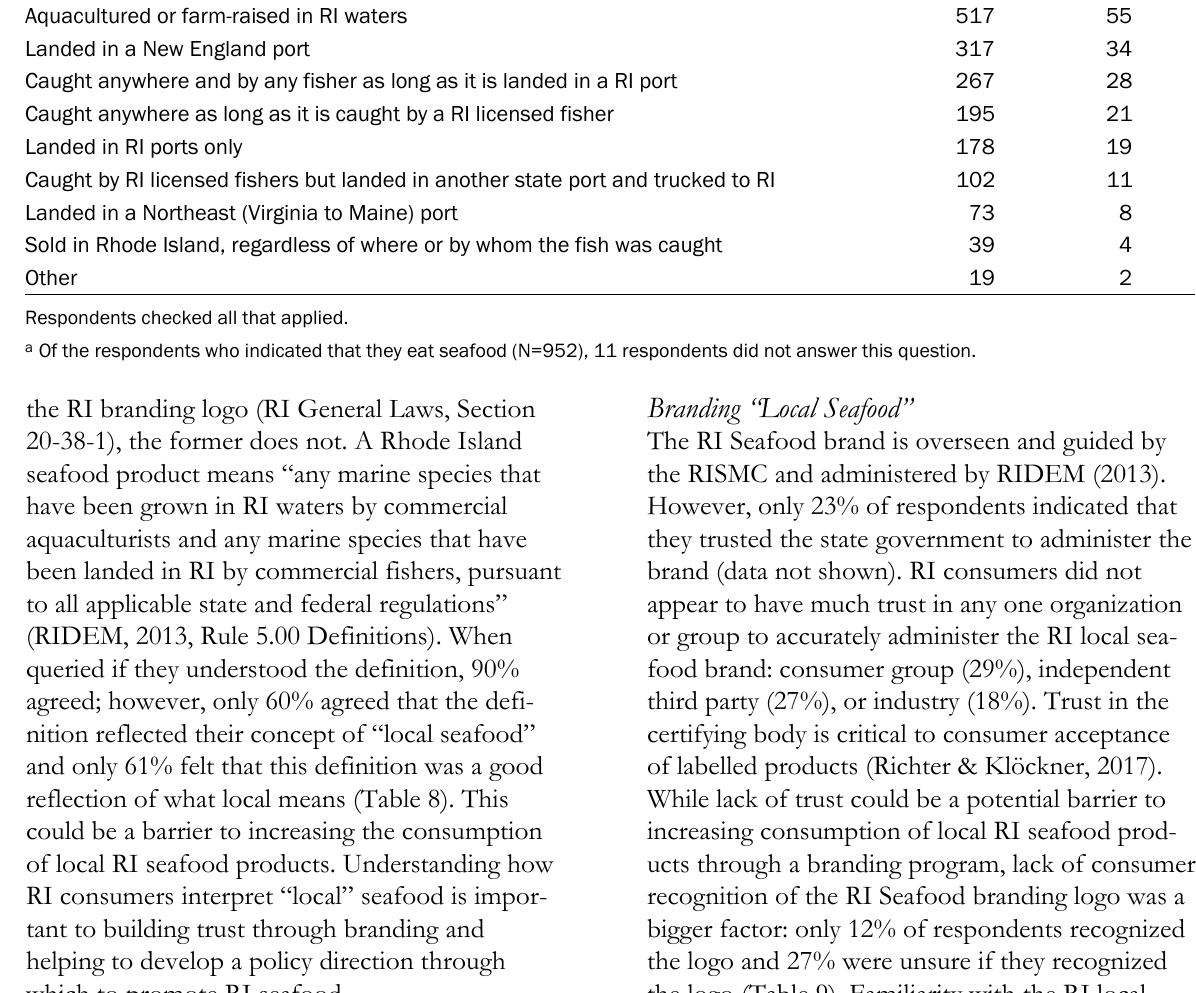
Table 7. Rank Order of Rhode Island Consumer Interpretation of “Local Seafood” ( N =941 a ) Fish or Shellfish Species Caught within Rhode Island (RI) state waters (the 3-mile limit) Aquacultured or farm-raised in RI waters Caught anywhere and by any fisher as long as it is landed in a RI port